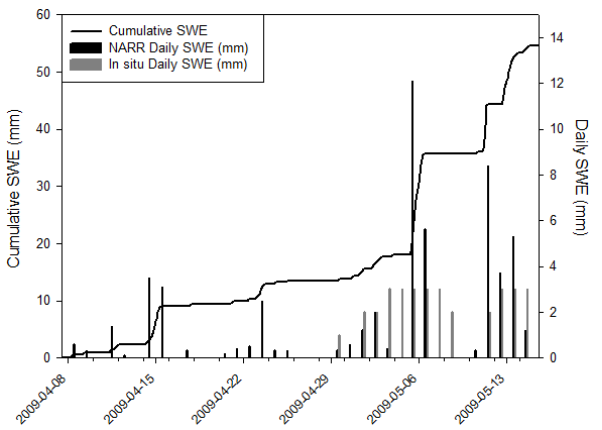
Figure 7. NARR precipitation events and SWE accumulation for the entire study period, with a comparison of in situ Nipher gauge observations for the period 30 April to 15